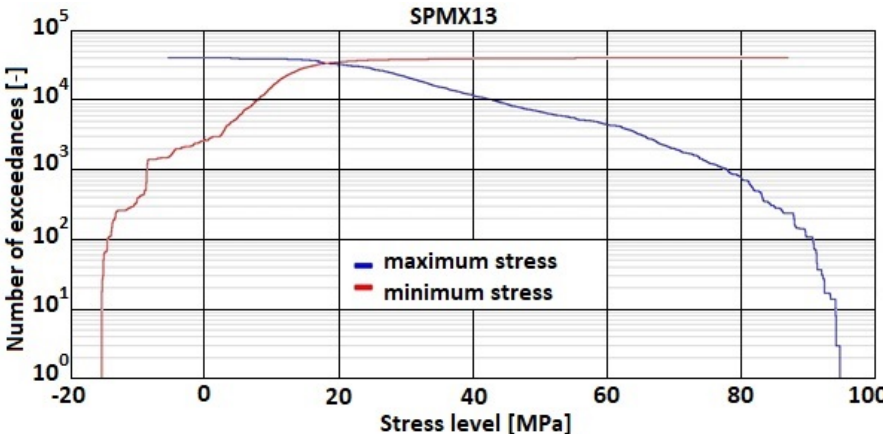
Figure 9. Exceedance plot of the defined load spectrum based on the strain gage data.